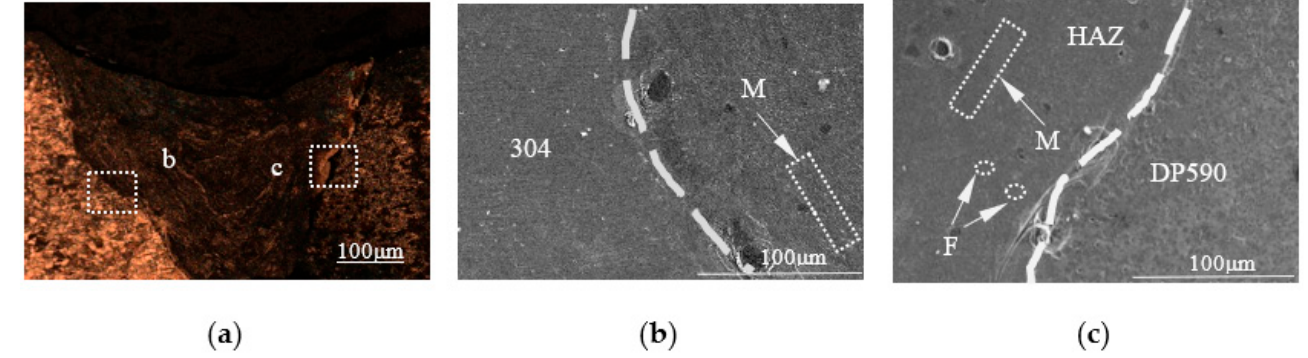
Figure 5. Pro fi le and microstructures of the welded joints with the preset nickel coating at a single- pulse energy of 15 J: ( a ) pro fi le; ( b ) boundary zone near 304; ( c ) boundary zone near DP590.